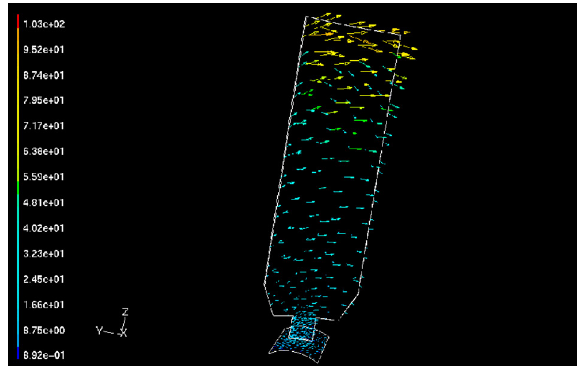
Figure 18: Velocity vectors on the pressure side of the domain with- out radiator (unit in